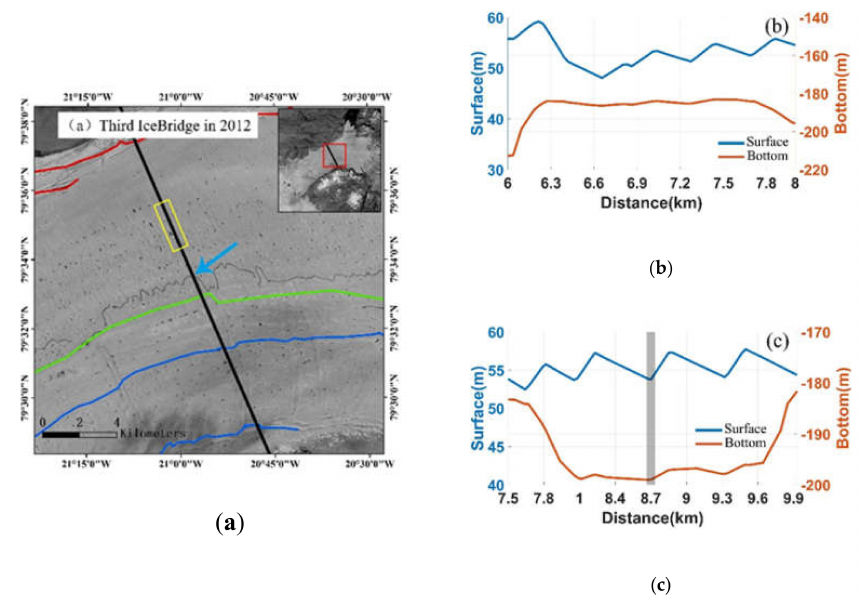
Figure 17. ( a ) Landsat image near the third IceBridge airborne radar flight path in 2012. Ocean-sourced basal channel (red solid line), grounding-line-sourced basal channel (Green solid line), subglacially-sourced basal channel (blue solid line). ( b ) IceBridge data corresponds to the position marked by the yellow solid box in ( a ). ( c ) IceBridge data with gray background represent a supraglacial river terrain indicated by blue solid arrow in figure ( a